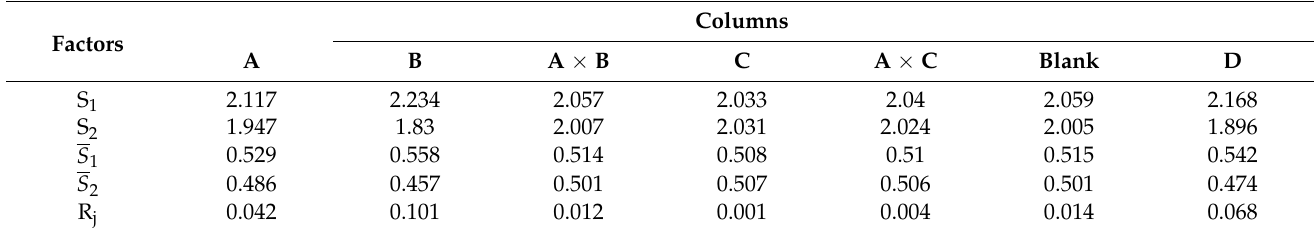
Table 6. Table 6. Analysis of